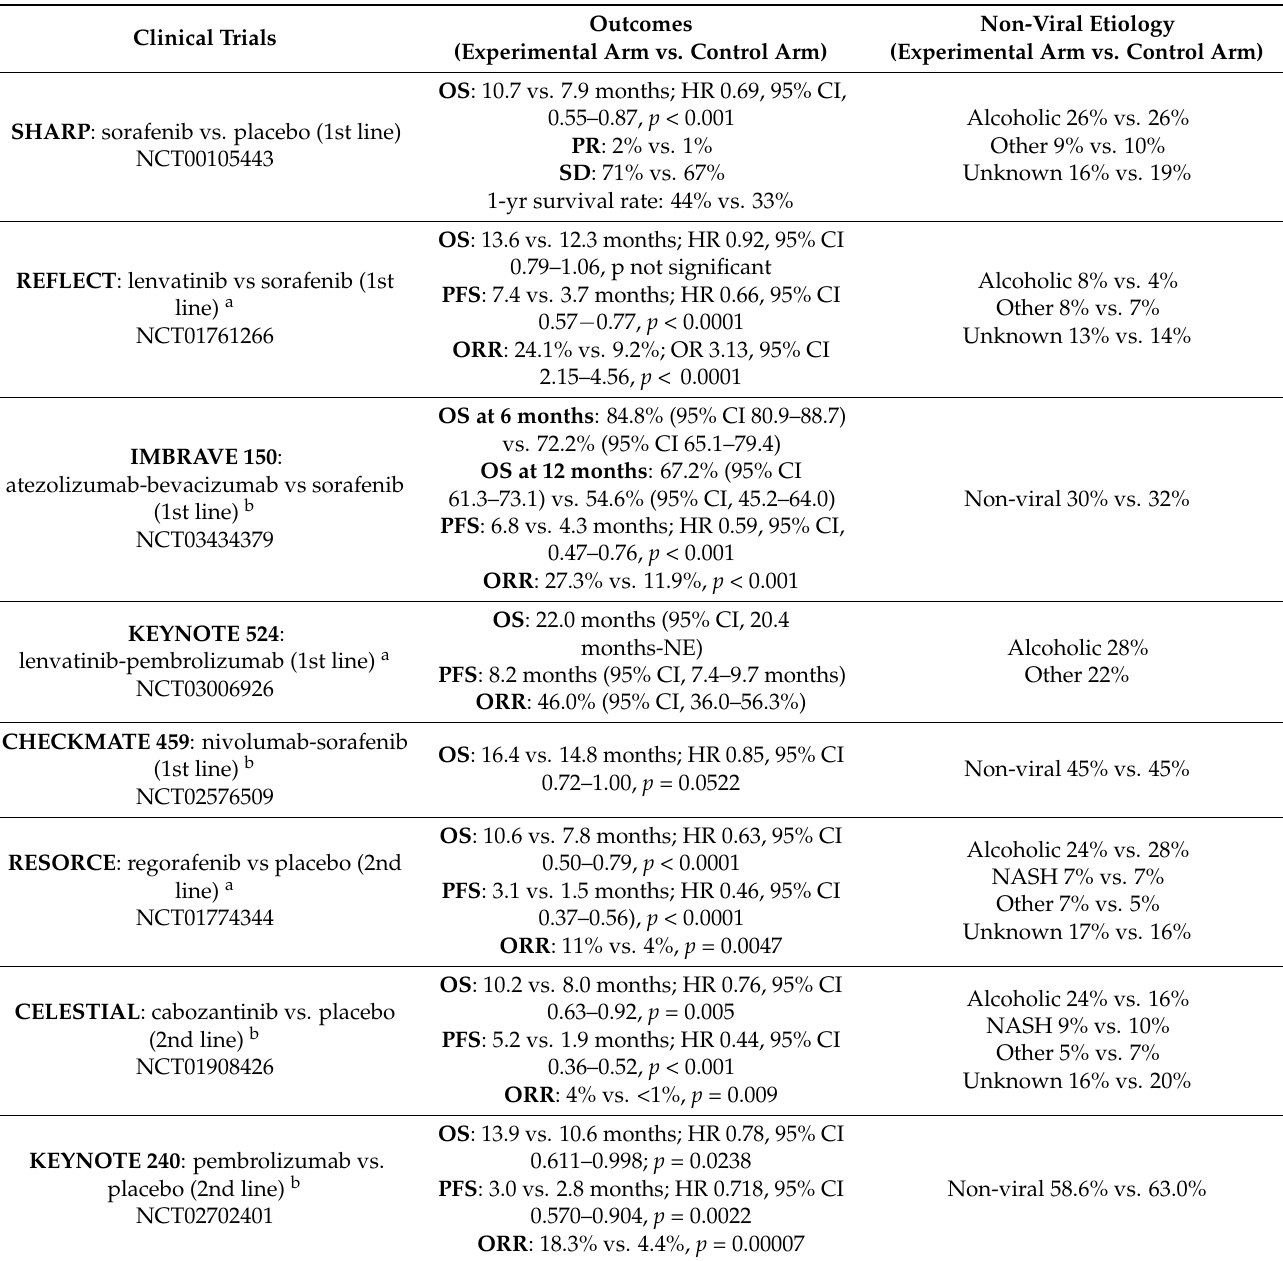
Table 1. Overview on main clinical trials on advanced HCC. Outcomes Clinical Trials (Experimental Arm vs. Control Arm)